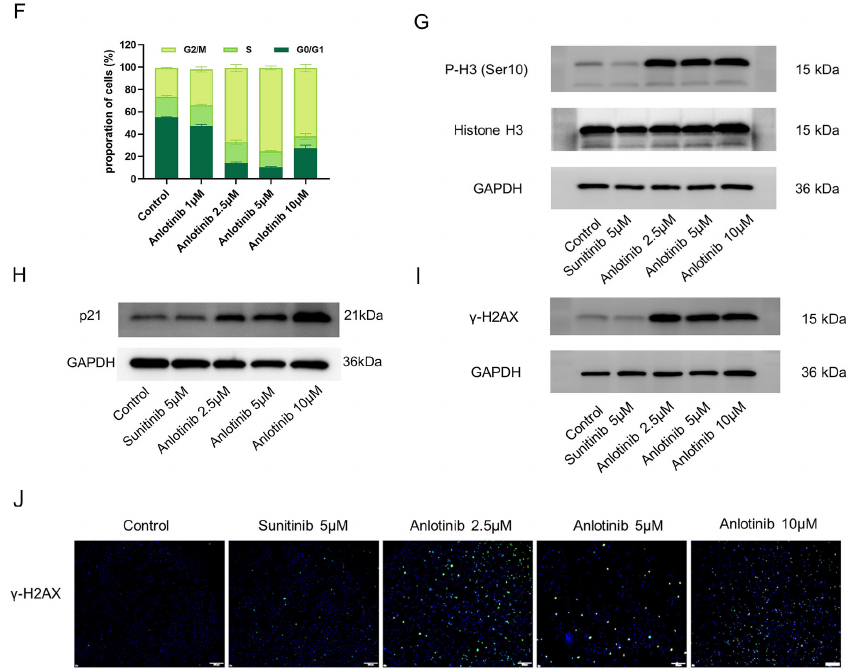
Figure 2. Anlotinib induced apoptosis and G2/M phase arrest of ovarian cancer cells. ( A – D ) The ratio of apoptotic cells was measured in SKOV-3 cells after anlotinib treatment for 24, 48, or 72 h. Apoptosis was detected using Annexin V-FITC and PI staining. The data are presented as the mean ± SD from three independent experiments. ( E , F ) Anlotinib induced G2/M phase arrest in SKOV-3 cells. The cells were treated with anlotinib at the indicated concentration for 48 h and analyzed by FCM after staining with PI. ( G ) The protein level of Histone H3 and its phosphorylation (P-H3 (Ser 10)) was detected by Western Blot in SKOV-3 cells treated with indicated concentration of anlotinib and sunitinib for 48 h. ( H ) The expression of p21 in SKOV-3 cells treated with indicated concentration of anlotinib and sunitinib for 48 h was detected by Western Blot. Phosphorylation of histone H2AX ( γ H2AX) was detected by western blot ( I ) and immunofluorescence staining ( J ). Bar = 200 µ m; * p < 0.05; ** p < 0.01; *** p < 0.001; ns,